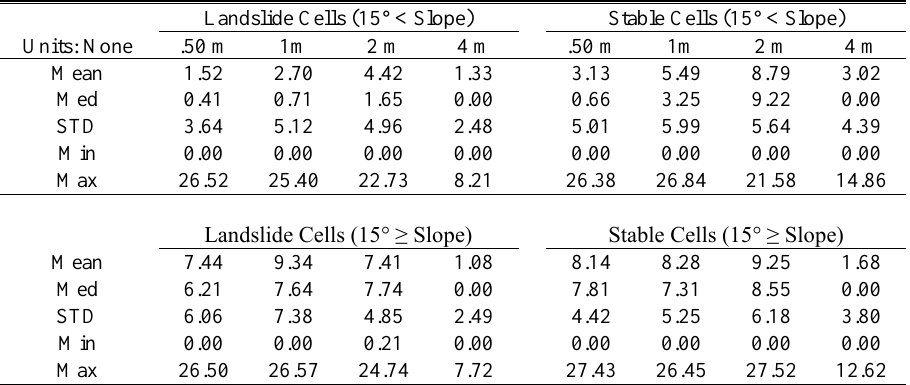
Table 9. Statistics of strength of mean vector R surface